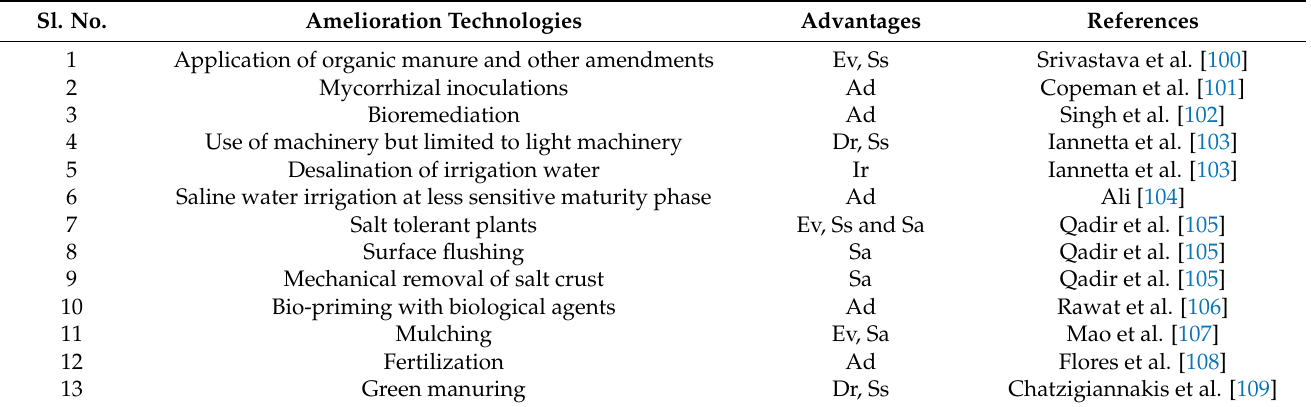
Table 4. A few common technologies advocated in ameliorating saline soils. Sl.